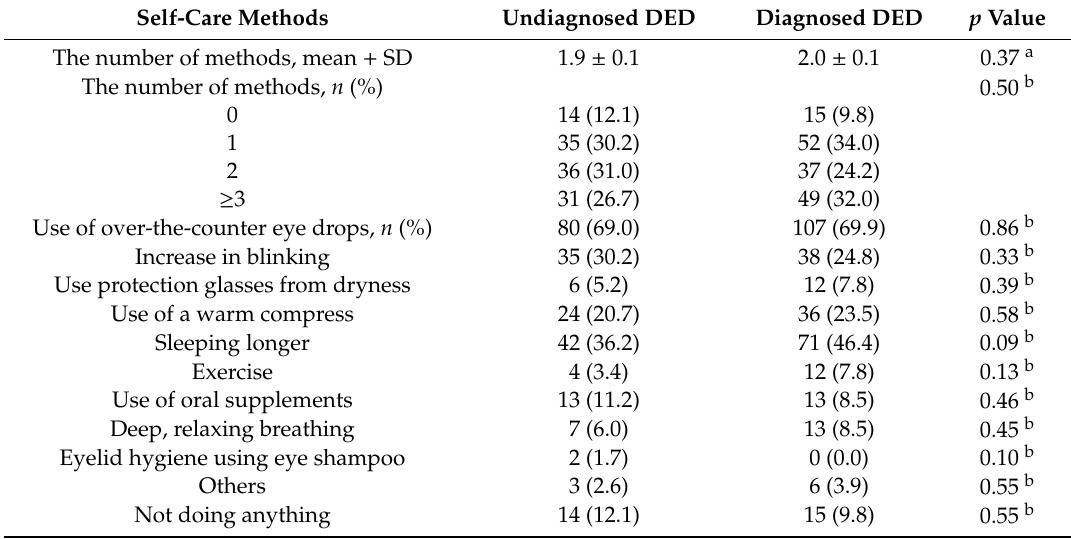
Table 4. The distribution of self-care methods among undiagnosed and diagnosed dry eye disease. Self-Care Methods Undiagnosed DED Diagnosed DED p